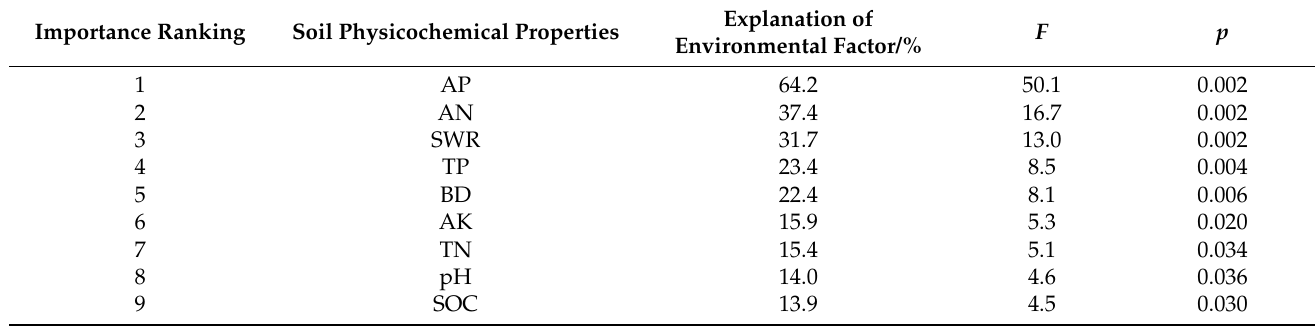
Table 6. Importance and significance level of soil physicochemical properties in APR